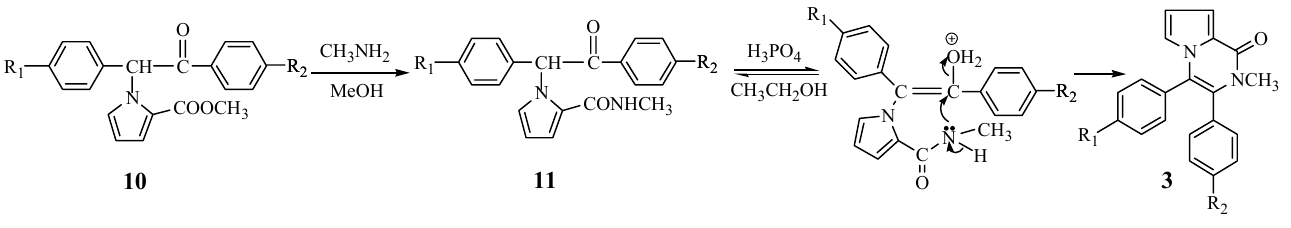
Figure 2. Proposed mechanism of the second